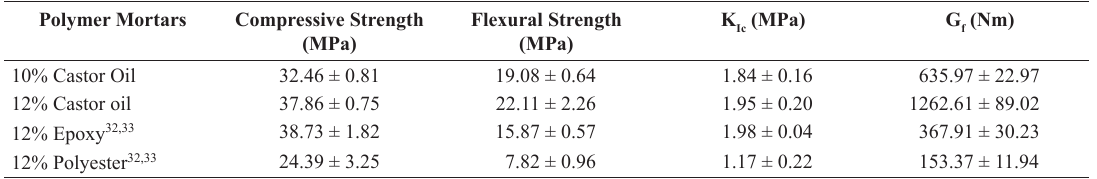
Table 2. Castor oil polymer mortar test results. Polymer